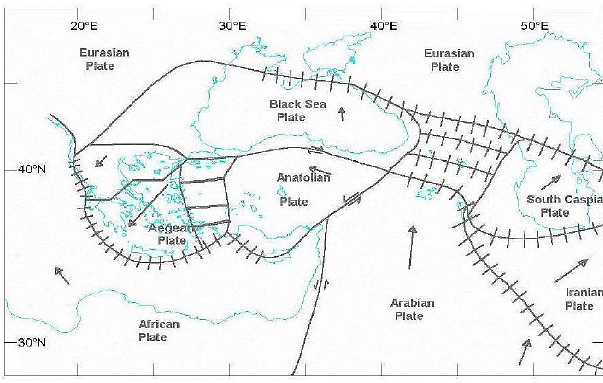
Fig. 2. Historical Seismicity with the Major Tectonic Features (Erdik et al., 1999).